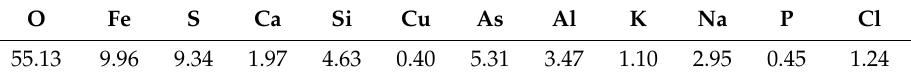
Figure 8. Micrographic ( × 350) sample of residue at pH 2 and 510 mV (C-3). Table 7. Percentage in weight of precipitates with arsenic content (EDX analysis).